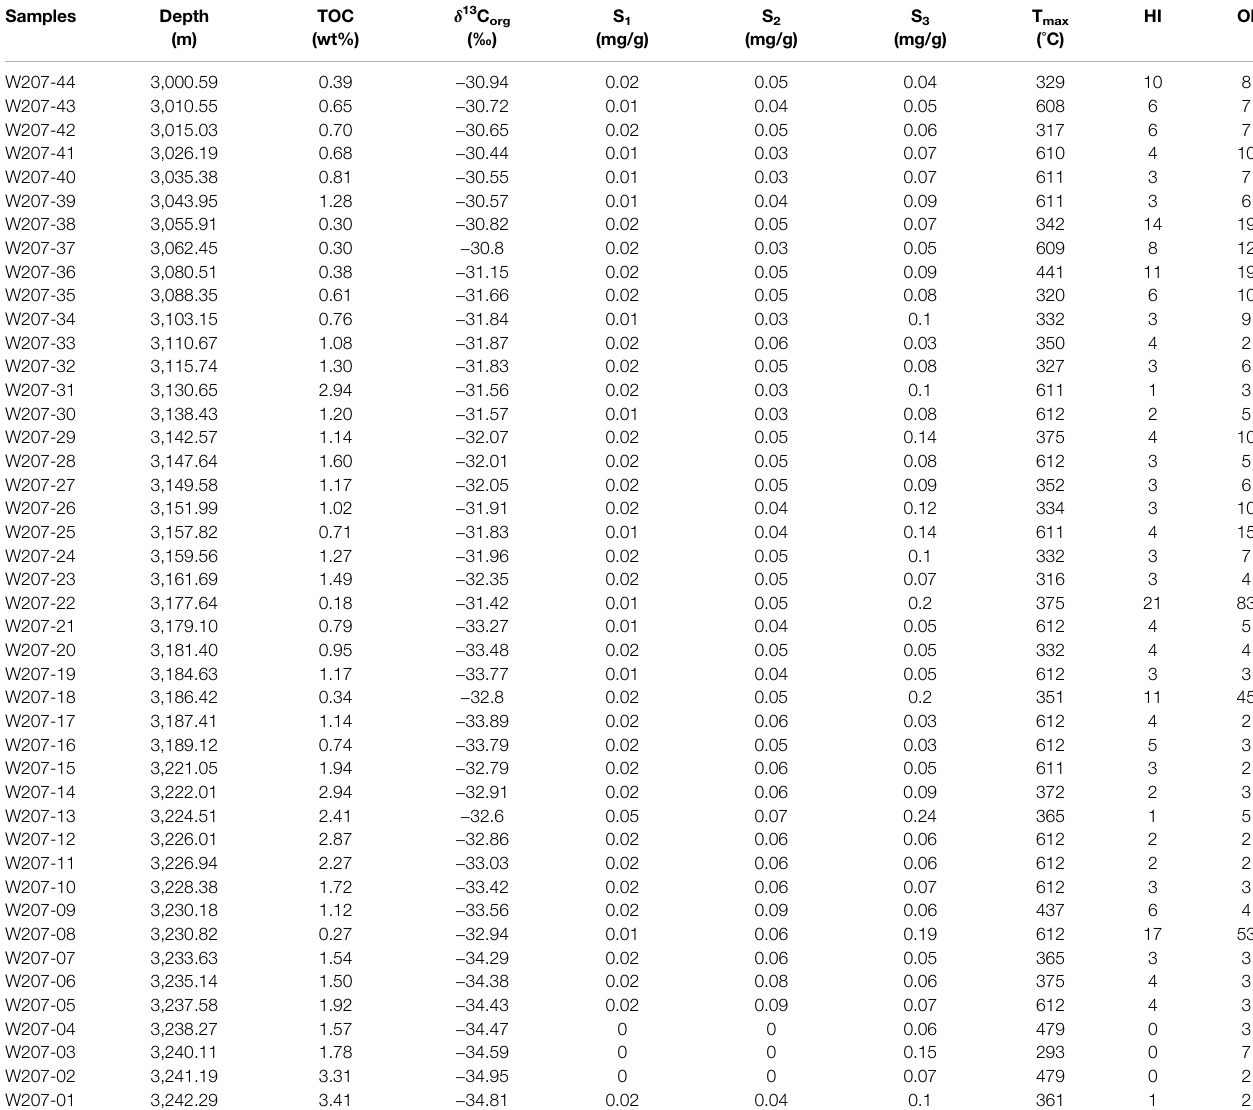
TABLE 1 | Organic geochemical parameters of Qiongzhusi Fm, W-207 Well.